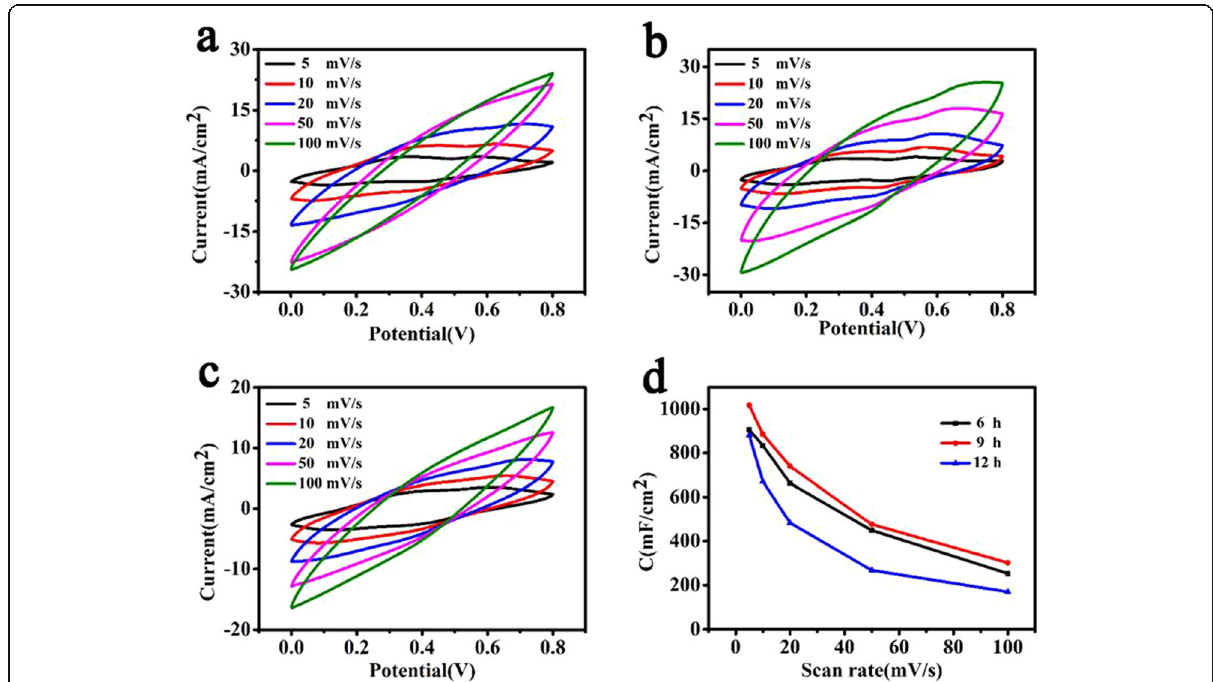
Fig. 5 The CV curves of the PVA/CNT/PANI film ( a ) 6 h, ( b ) 9 h, ( c ) 12 h; ( d ) specific capacitances of PVA/CNT/PANI film with increasing scan